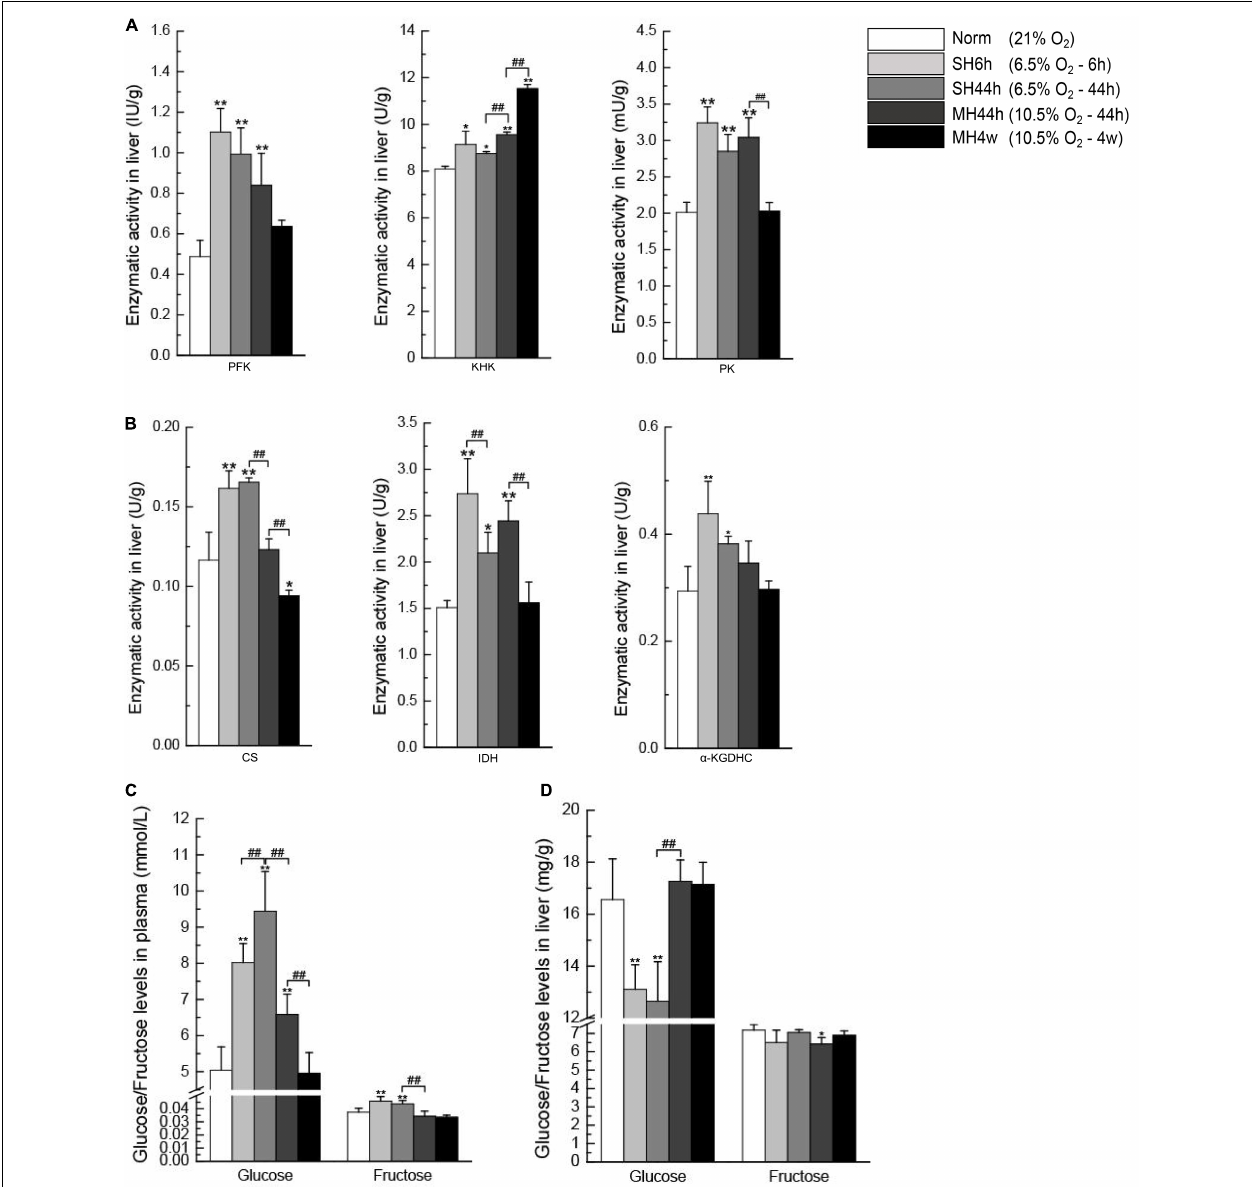
FIGURE 9 | Enzymatic activity analyses of carbohydrate metabolism and glucose and fructose levels in the plasma and the liver. The activities of PFK, KHK, and PK (A) and CS, IDH, and α -KGDHC (B) . Plasma glucose and plasma fructose levels (C) . Liver glucose and liver fructose levels (D) . All data are presented as mean ± SD. Statistical symbols: * P < 0.05 and ** P < 0.01 between the normoxia and hypoxia treatment; ## P < 0.01 between two hypoxic groups under the same oxygen concentration or the same treatment duration.